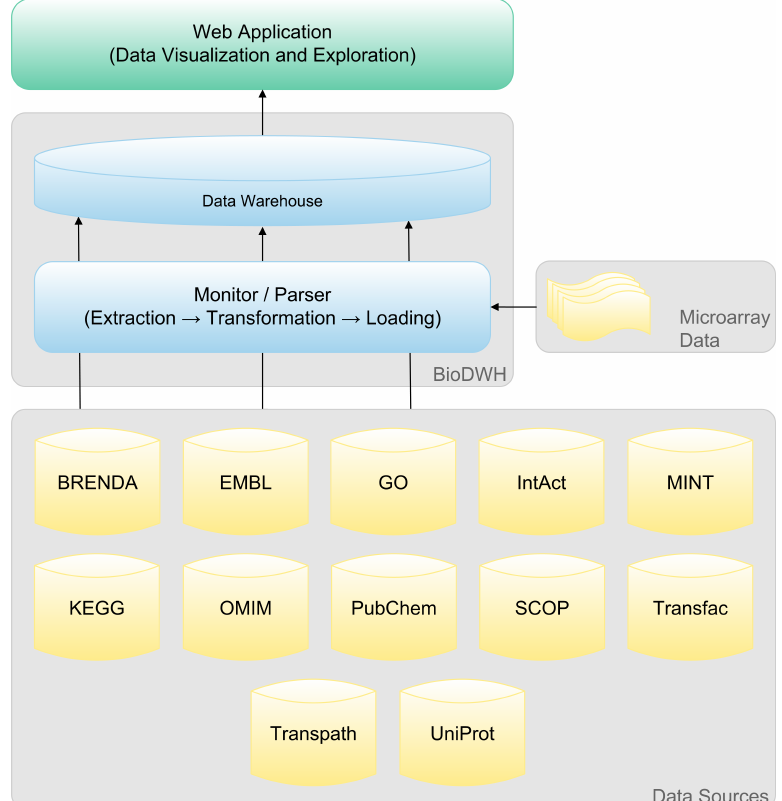
Figure 2: Schematic representation of the CardioVINEdb 3-layer system architecture from the original heterogeneous data sources to the web application layer. The data source layer con- tains flat files of the different data sources. The data warehouse infrastructure BioDWH is used to extract, transform and to load the data from different molecular biology data sources into the data warehouse (ETL-Process). Also microarray data can be integrated into the data ware- house by BioDWH. The web application layer represents the web-based graphical user interface of CardioVINEdb that allows the user to find information of interest from the different databases illustrated in the data source layer. Furthermore, a network-based visualization enables intuitive and comfortable exploration of the integrated